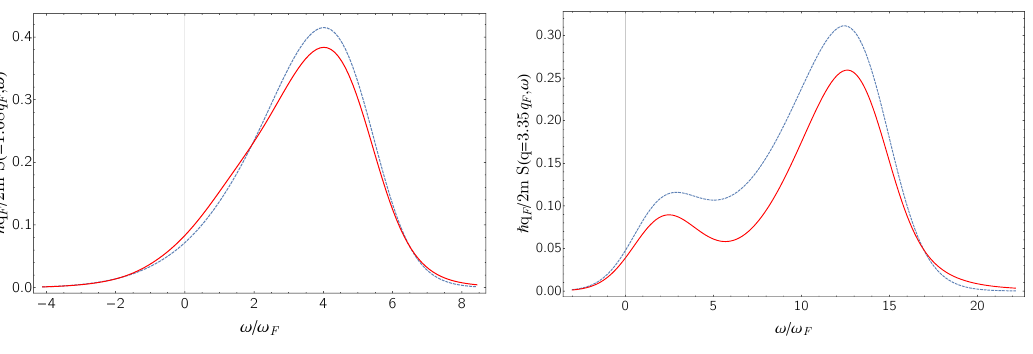
Figure 7: Same as Figure 6 but for q = 1.68 q